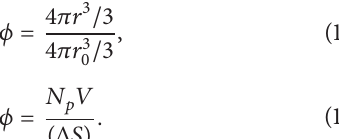
Figure 6: Transmissibility of the isolation system without negative stiffness.